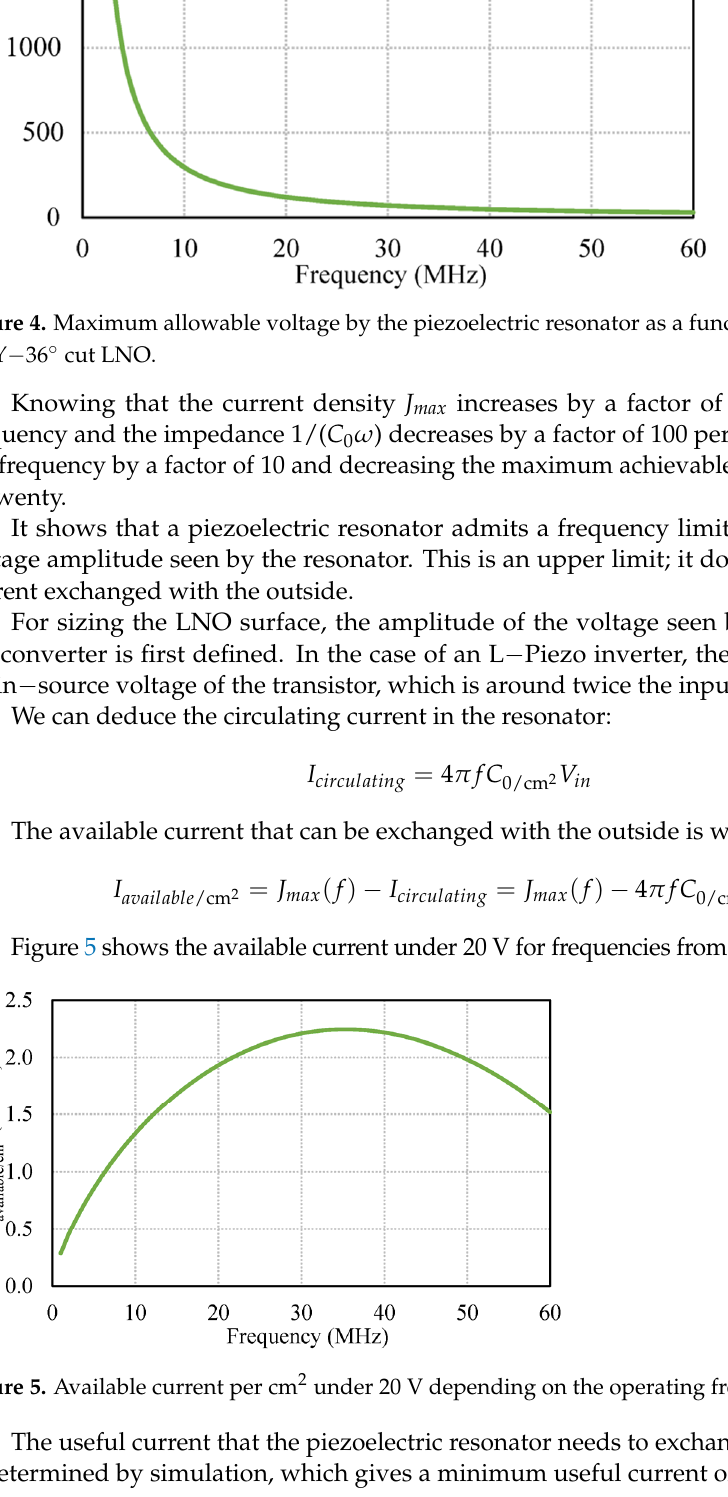
Figure 5. Available current per cm 2 under 20 V depending on the operating frequency for LNO.